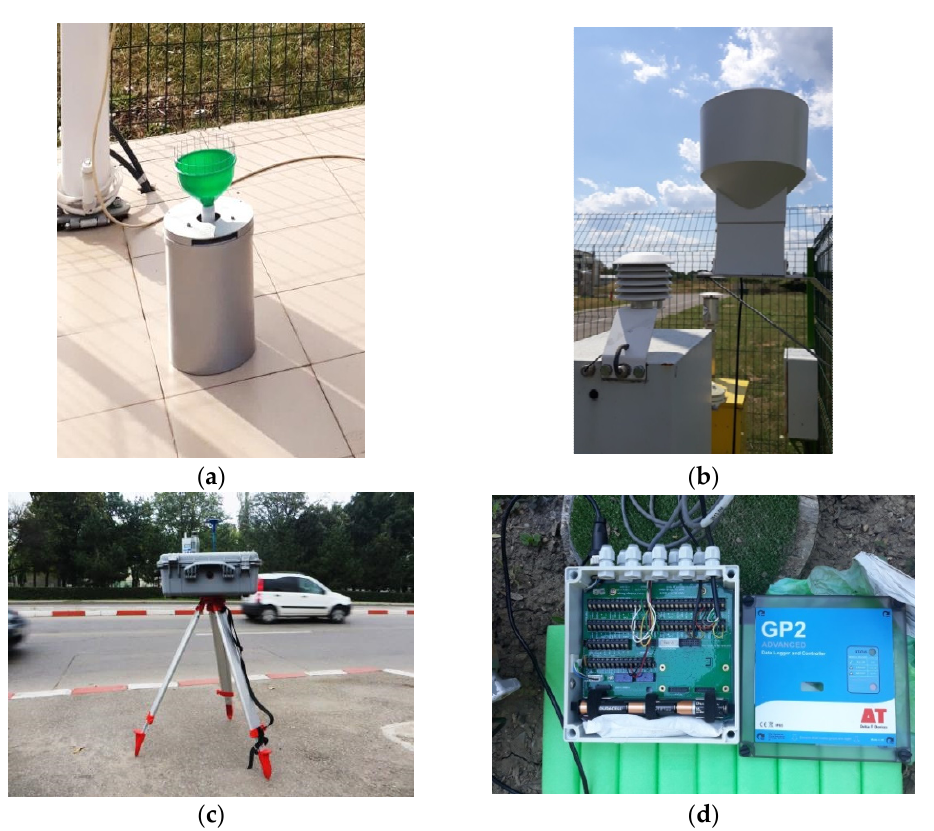
imetric sampler), Rokidair Optical Monitor (PM monitoring), and a Delta-T Devices weather station.